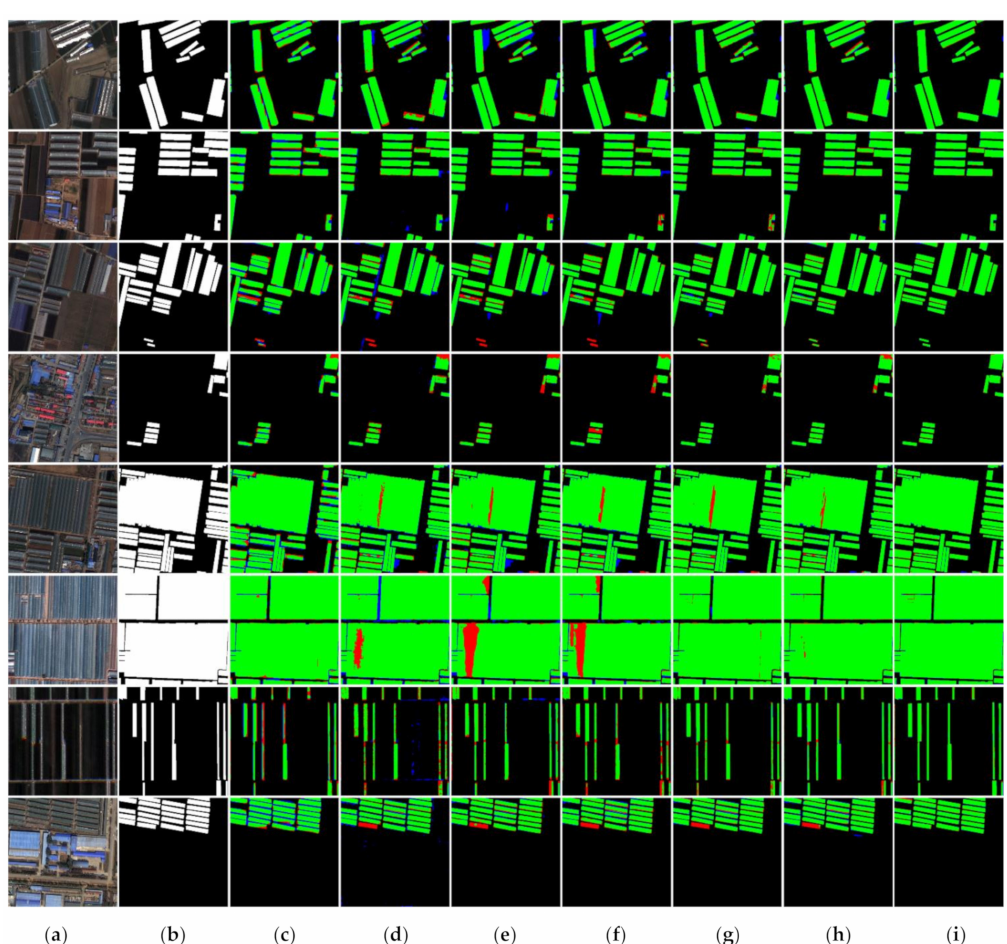
Figure 11. Examples of AG extraction results produced by multiple approaches. ( a ) Original image; ( b ) Ground truth; ( c ) FCN; ( d ) SegNet; ( e ) PSPNet; ( f ) DeepLabV3+; ( g ) UNet; ( h ) HRNetV2; ( i ) HBRNet. Notably in column ( c – i ), green, blue and red stand for true positive, false negative and false positive,